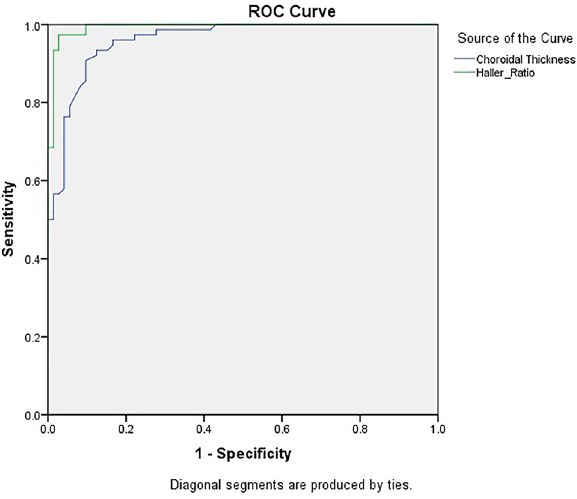
Figure 6. The receiver operating characteristic curve of the choroidal thickness and Haller ratio for the cluster membership variables obtained from cluster